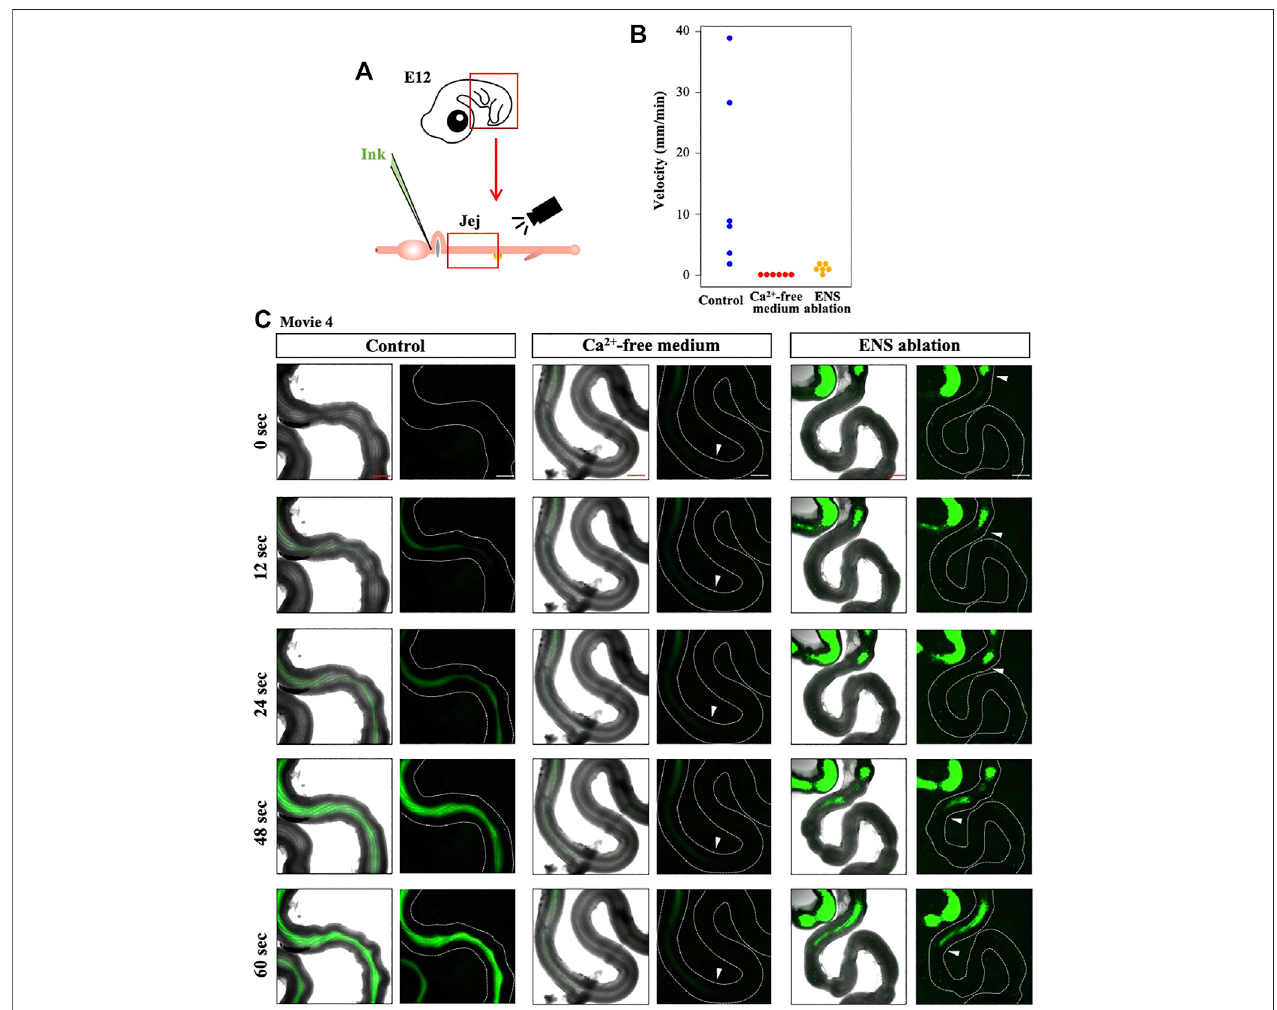
FIGURE 6 | Requirement of ENS for smooth transportation of inter-luminal content in E12 jejunum. (A) Fluorescent ink is injected into duodenum using capillary, followedbyvideorecordingofjejunum. (B) Velocityoftheinjectedinkinthejejunum.Eachdotrepresentssinglejejunumduringsixrepeats(embryos).Jejunaimmersedin control and in Ca 2+ -free media, and ENS-ablated jejunum are assessed and compared. (C) Five frames are selected from each of movies ( Supplementary Video S4 ). Arrowheads indicate a front position of the ink moving in an oral-to-aboral direction, although the ink transportation in the control jejunum is too fast to stay in a picture frame. Scale bars: 500 μ